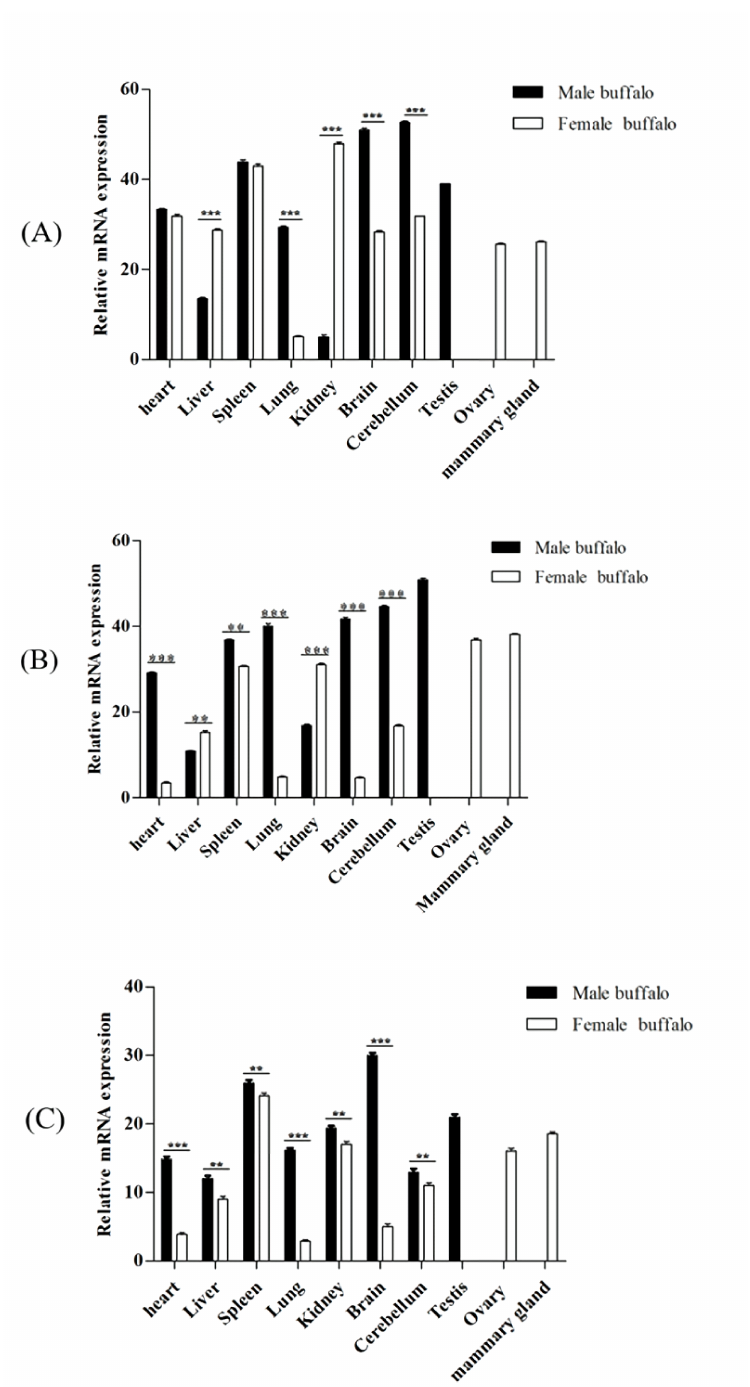
Figure 8. Multi-tissue expression profiles of buffalo Smads 1 , 4 , and 5 genes in male and female buffalo. ( A ) Smad1 , ( B ) Smad4 , ( C ) Smad5 . The values are provided as means ± SE (** p < 0.01, *** p <